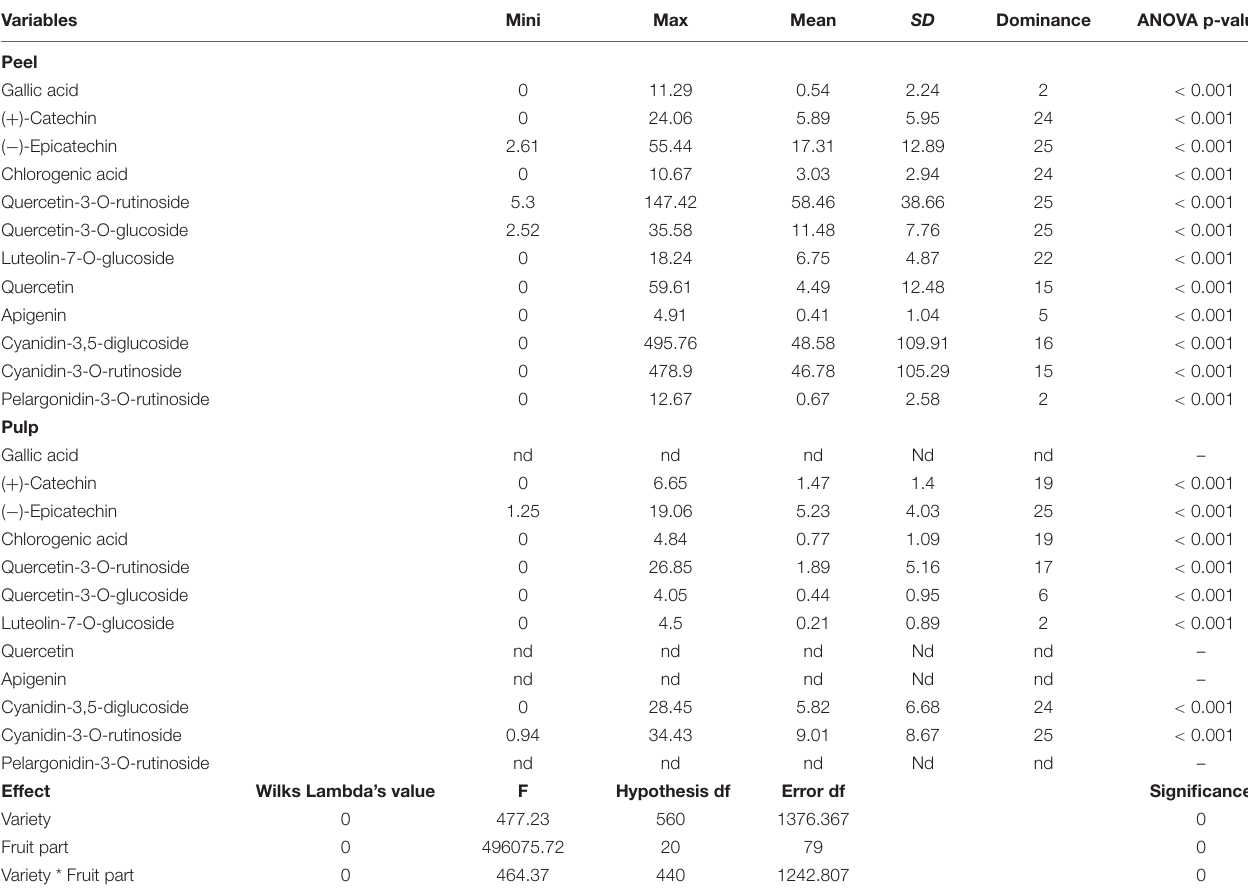
TABLE 2 | Descriptive analysis and multivariate ANOVA of all studied variables over fig peels and pulps.